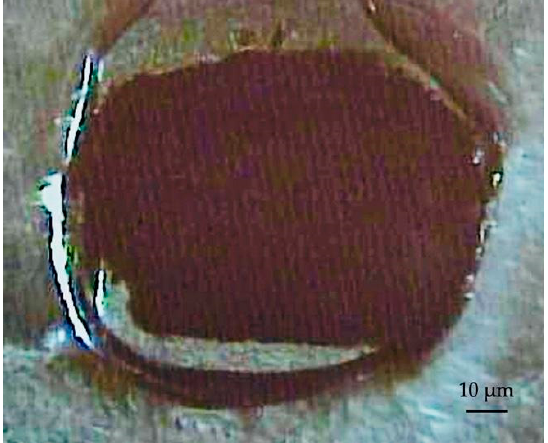
Figure 3. Optical microscopy image of the micrometeorite WestIslipB embedded in petrolatum at 100×.